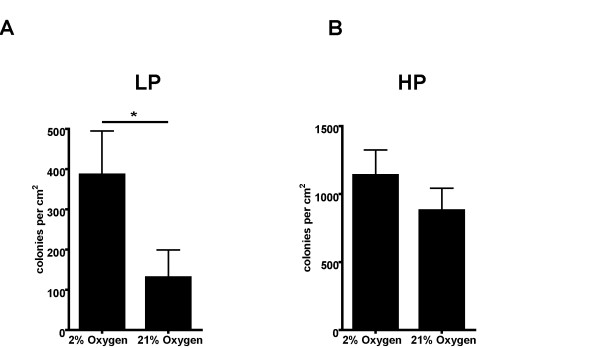
Anchorage-independent growth in soft agar at different oxygen conditions. A: Growth of Ras-LP cells in soft agarat 2% and 21% environmental oxygen. Lowering external oxygen levelsresults in a 3-fold increase in the number of colonies per cm2. *:p < 0.05 (Student's t-test). B: Growth of Ras-HP cells in soft agar at2% and 21% environmental oxygen. Lowering external oxygen levels inRas-HP soft agar cultures results in only a marginal 1.3-fold andnon-significant increase in colony number, showing that a glycolyticshift in these relatively glycolytic cells does not result in a largeincrease in viability and colony formation of cells in the soft agar.